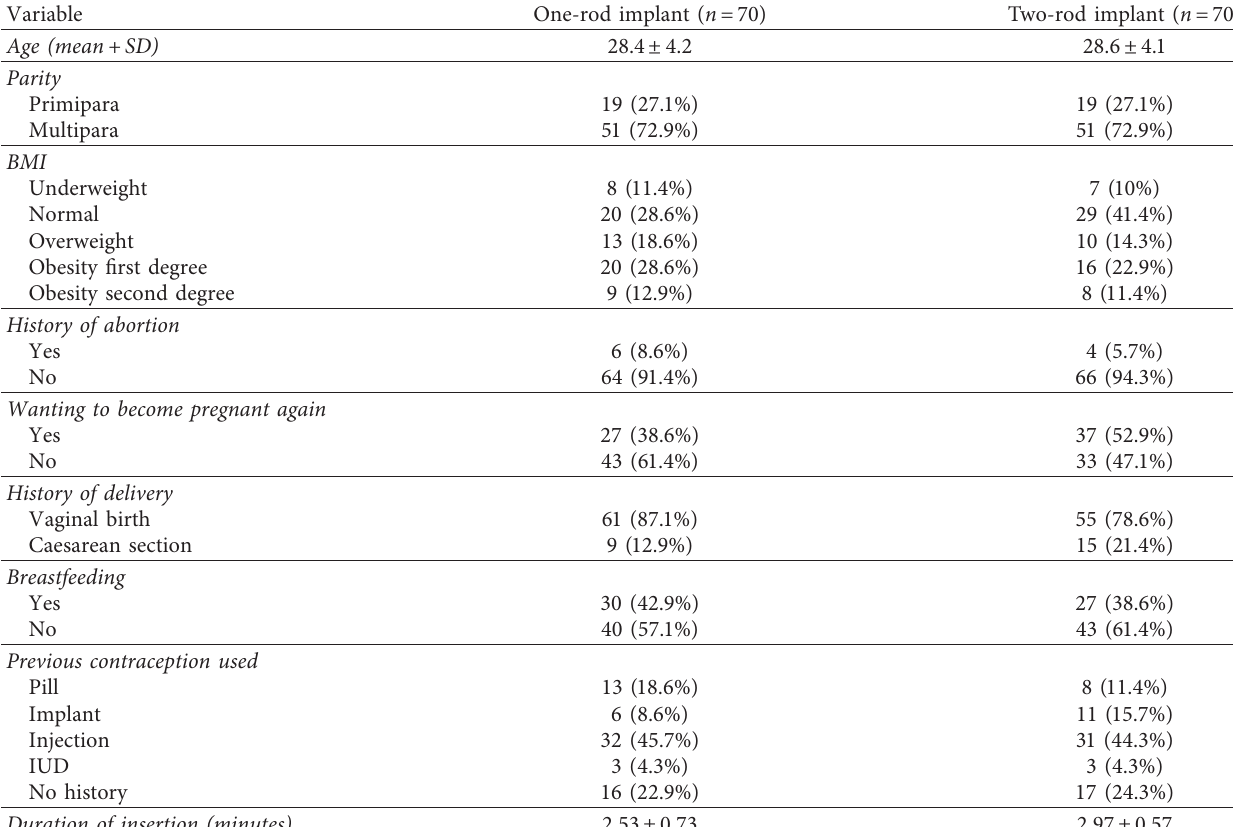
Table 1: Baseline characteristics of subjects receiving one-rod and two-rods implant.